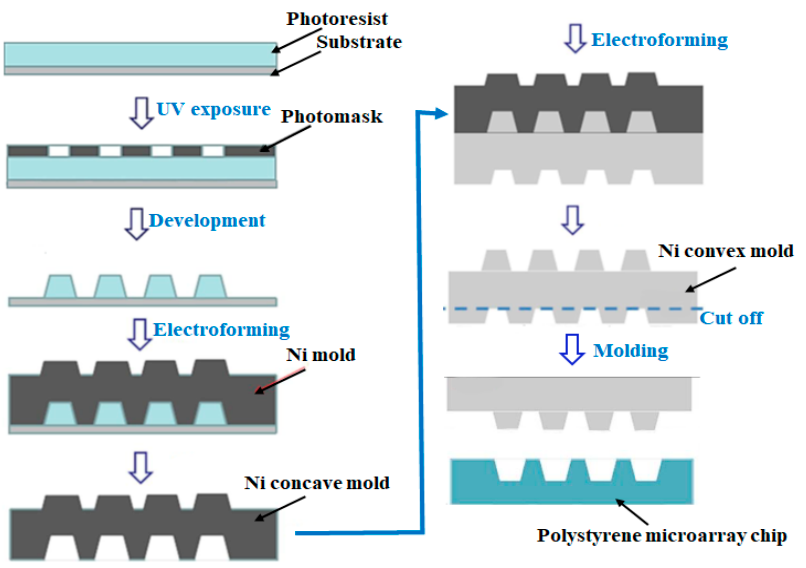
Figure 2. A schematic of the Ultraviolet-Lithographie Galvanoformung Abformung (UV-LIGA) process used for the fabrication of the single-cell microarray chip.